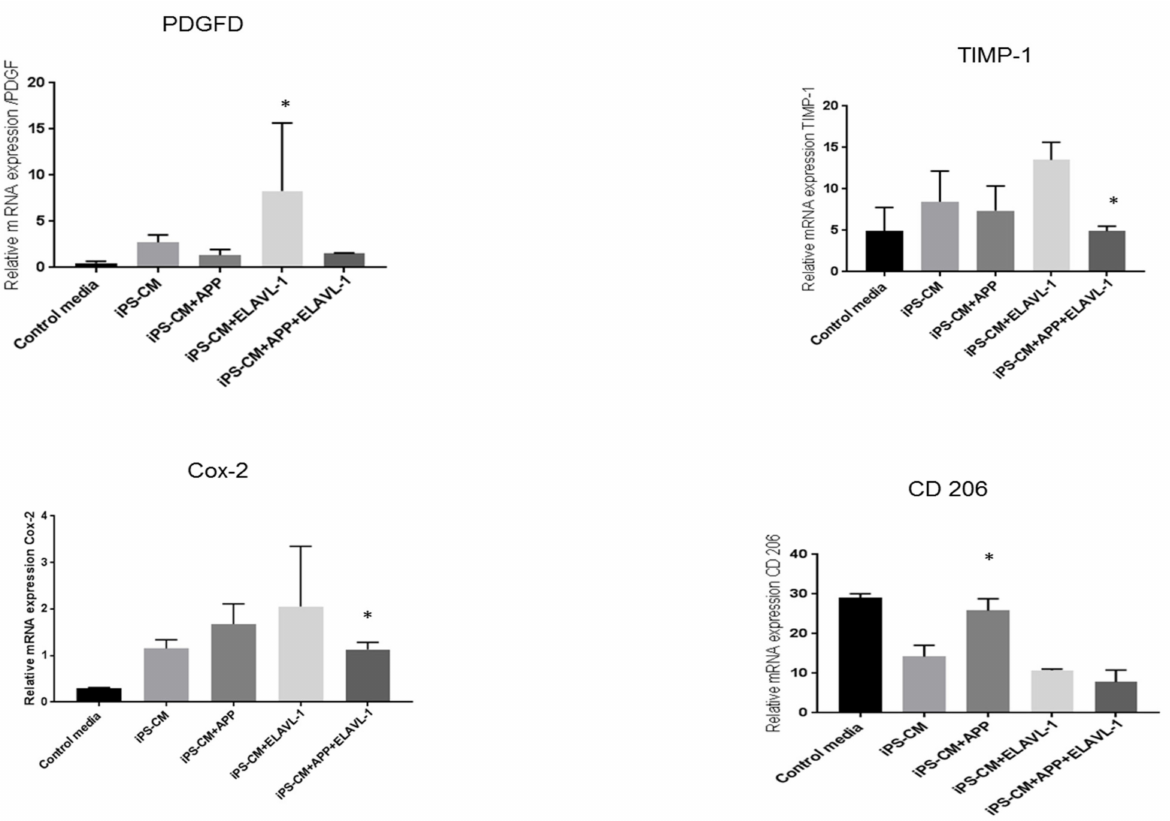
Figure 5. Relative mRna expression in M2a subpopulation after iPSC-CM treatment. Values are represented as Mean ± SEM; *: p <